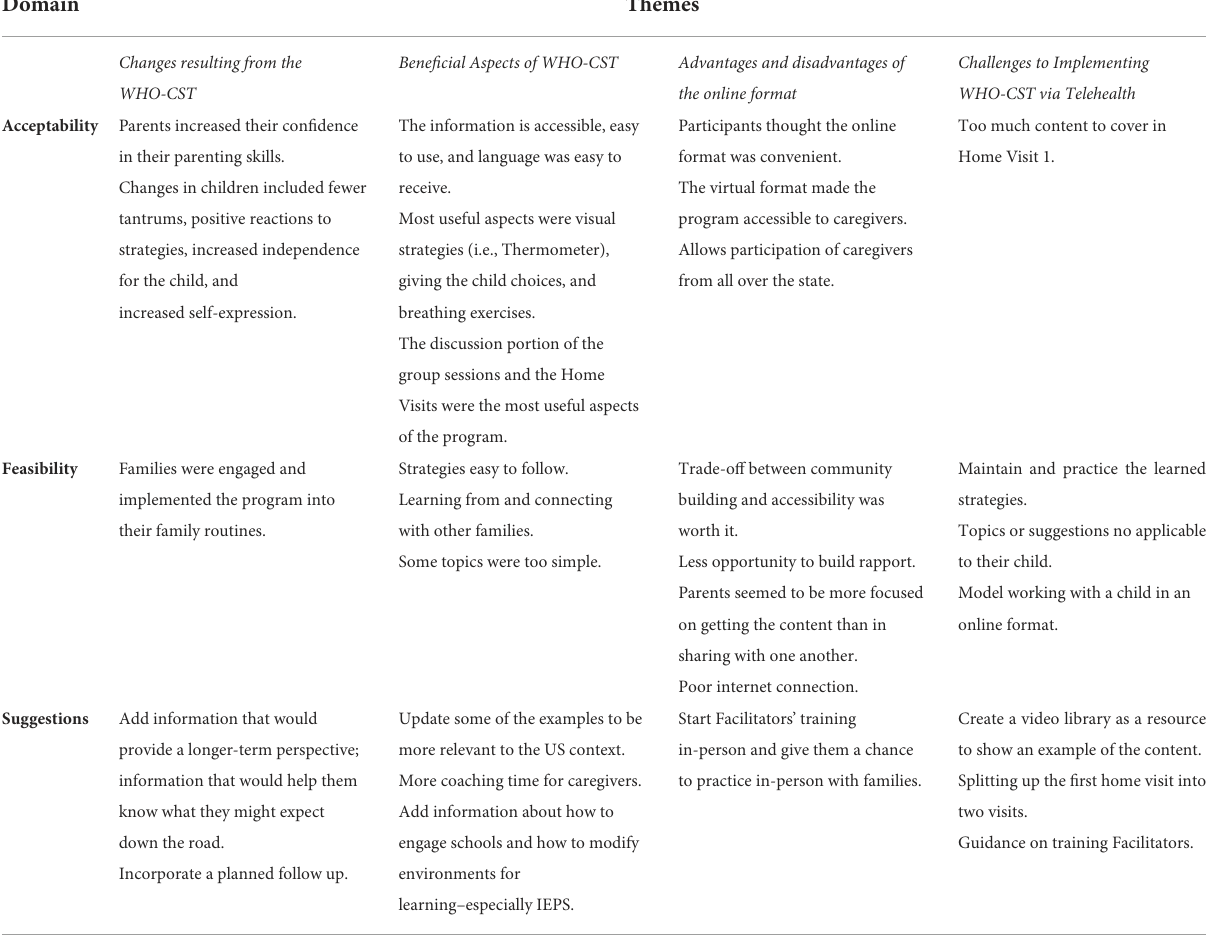
TABLE 8 Feasibility, acceptability, and suggestions: themes developed from focus groups with caregivers and Master Trainers.